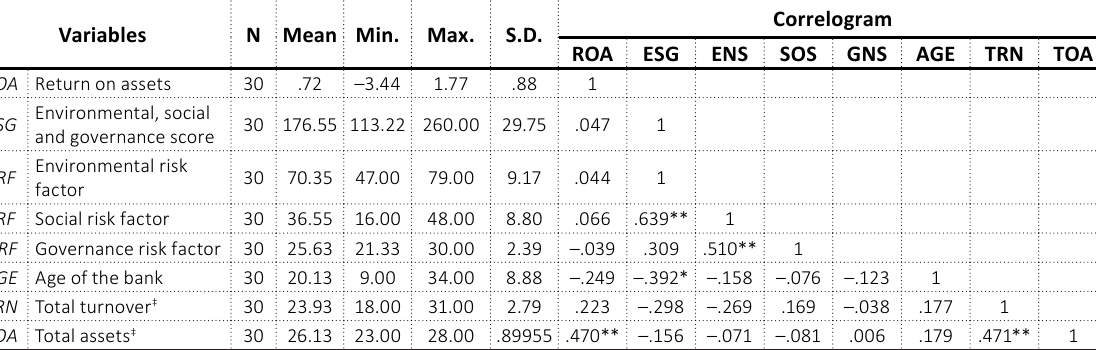
Table 4. Descriptive statistics and Pearson correlations (2018) Variables